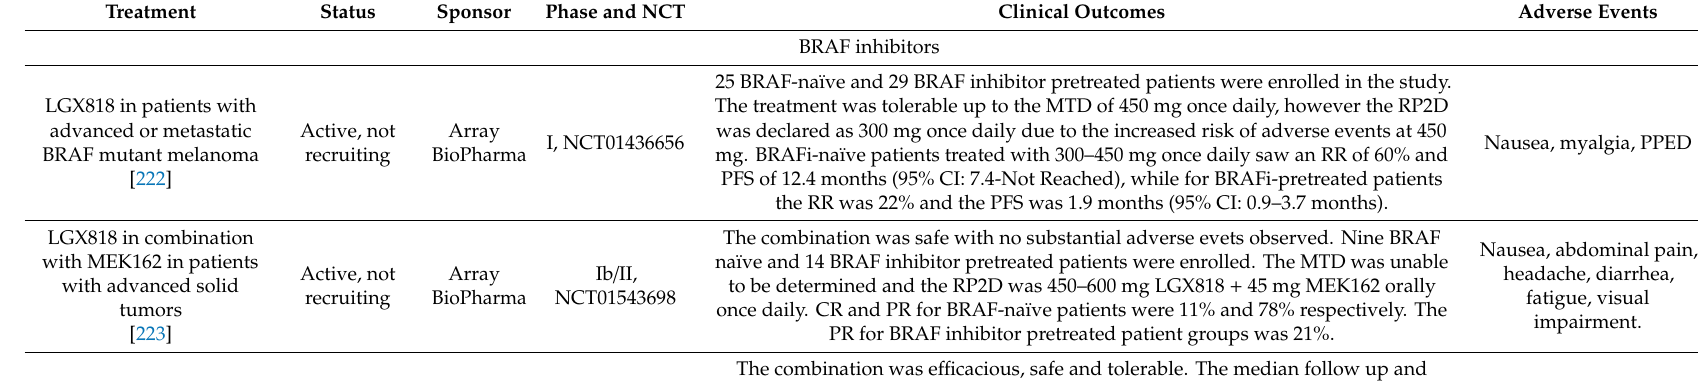
Table 2. Summary of clinical trials, outcomes and adverse events associated with novel BRAF inhibitors and ERK inhibitors in patients with metastatic melanoma.